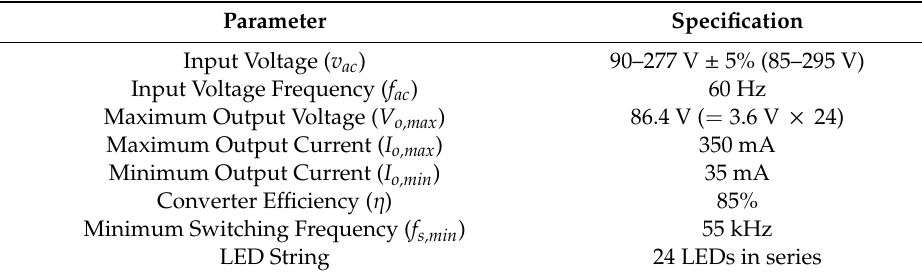
Table 1. System specifications without the linear current regulator considered.